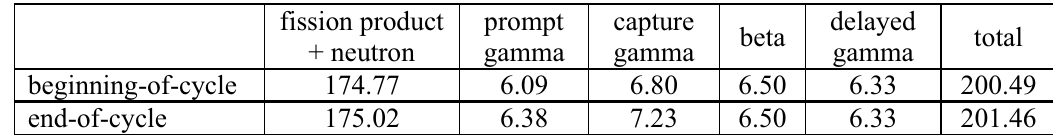
Table III. Fission Q-values [MeV/fission] for the Optimized core design.